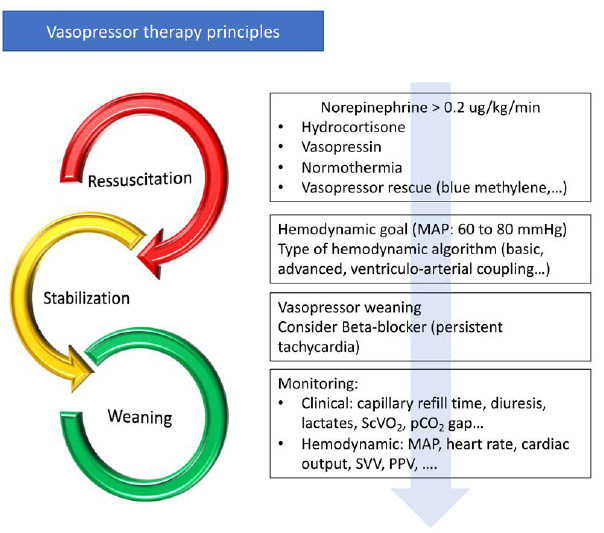
Figure 2. Principles of vasopressor treatment. MAP—mean arterial pressure; ScVO 2 —central venous oxygen saturation; pCO 2 Gap—difference between partial pressure of CO 2 in venous blood and arterial blood; SVV—stroke volume variation; PPV—pulse pressure